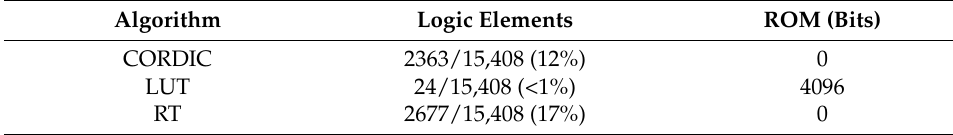
Table 6. Comparison of the resource consumption using the related algorithms. Algorithm